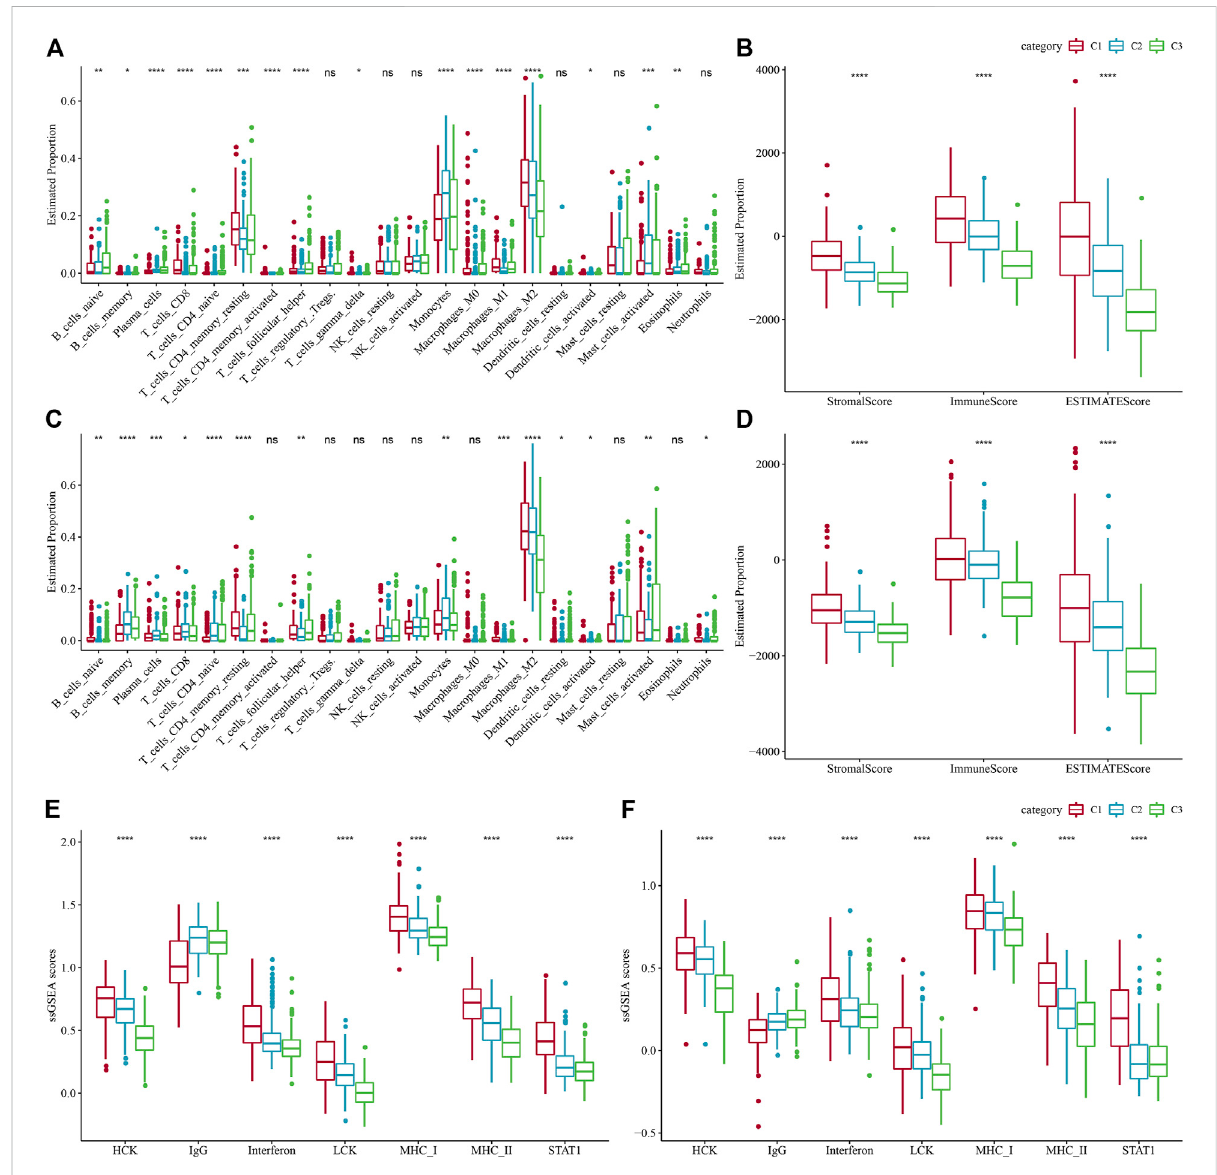
FIGURE 5 Levelofimmunecellin fi ltration invariousmolecular subtypes. (A) Differencesin22immunecell scores betweenvariousmolecular subtypes in the TCGA-LGG cohort. (B) Differences in 22 immune cell scores between different molecular subtypes in the CGGA cohort. (C) Variations in ESTIMATE immune in fi ltration among different molecular subtypes in the TCGA-LGG cohort. (D) Differences in ESTIMATE immune in fi ltration between different molecular subtypes in the CGGA cohort. (E) TCGA-LGG cohort differences in seven in fl ammation-associated gene cluster scores between different molecular subtypes. (F) CGGA cohort variations in seven in fl ammation-associated gene cluster scores in various molecular